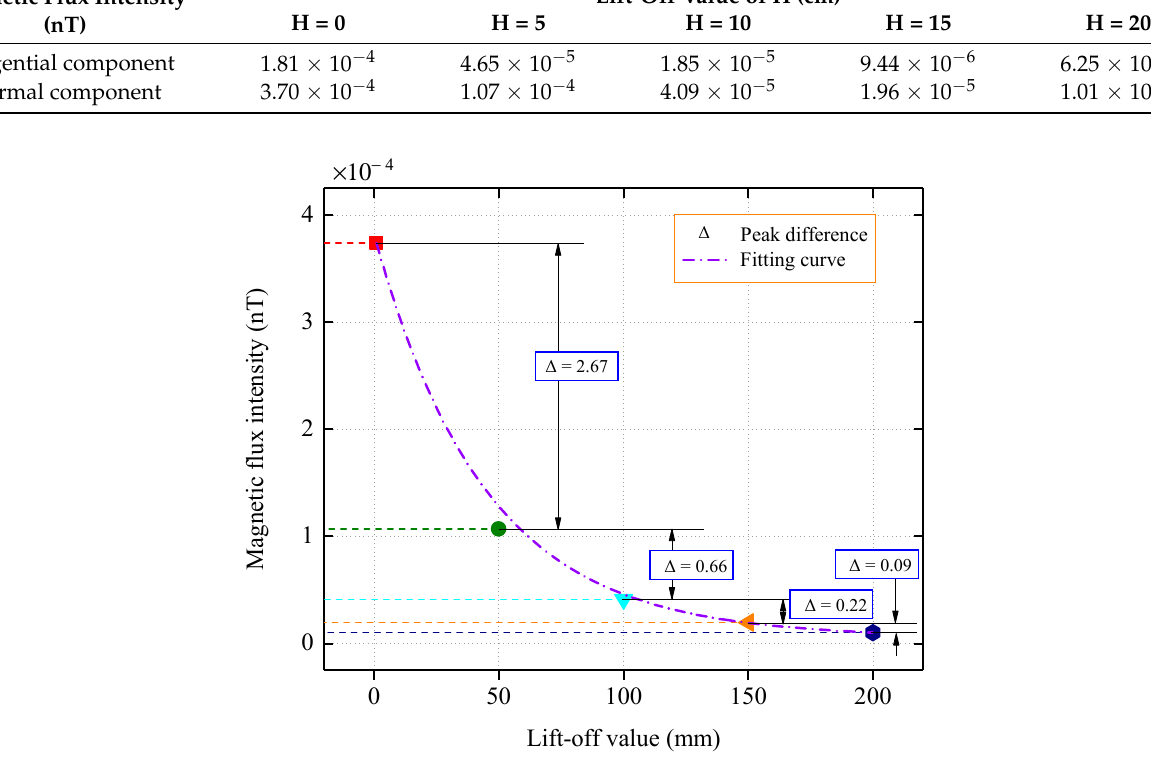
Figure 7. Normal component peak contrast.